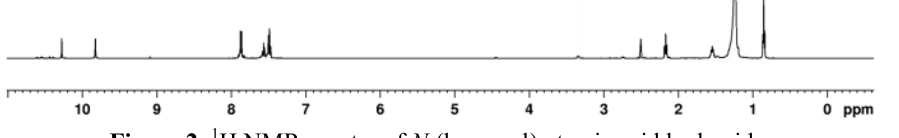
Figure 2. 1 H NMR spectra of N -(benzoyl) stearic acid hydrazide.